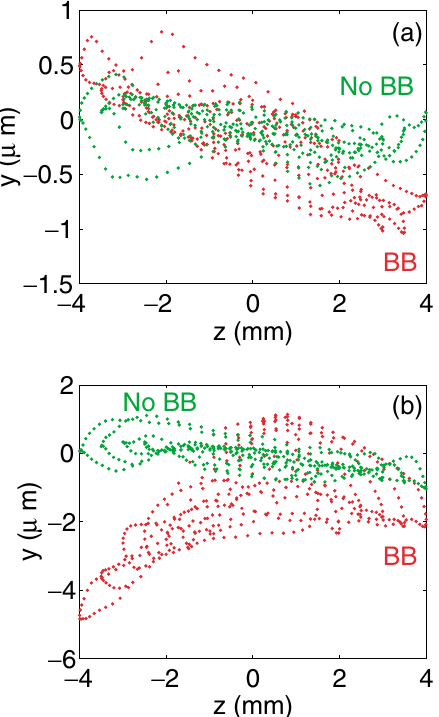
FIG. 5. (Color) Combined effect of beam-beam and beam- electron cloud interactions. The two curves correspond to the of the macroparticles with and variation of maximum J y; max without beam-beam interaction. The horizontal green line p . indicates (cid:3)(cid:3)(cid:3)(cid:3)(cid:3) " y